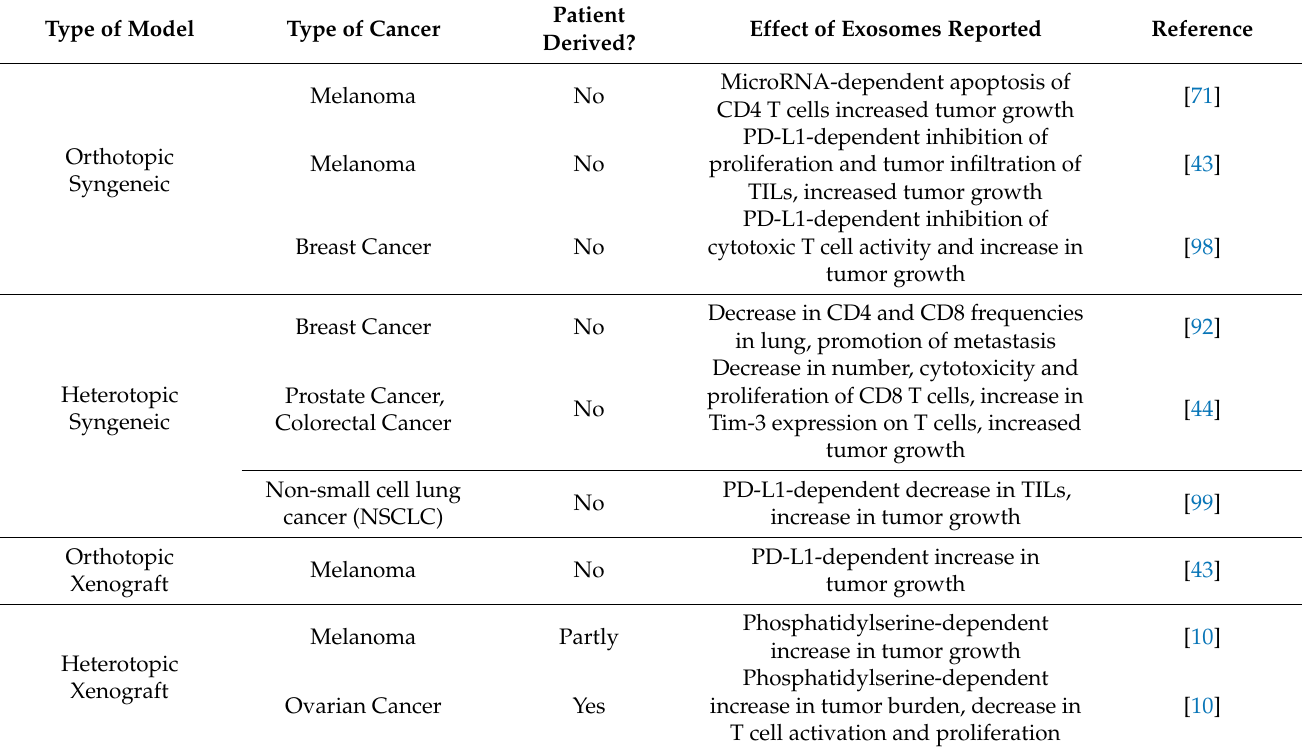
Table 1. Summary of different in vivo models developed to study tumor-associated exosomes and their effects on T